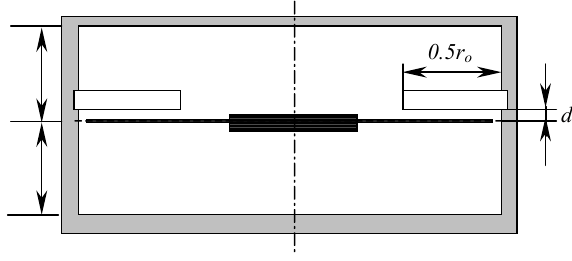
Figure 9. Passive Squeezing Plates for Rotating Disk Vibration/Flutter Control.